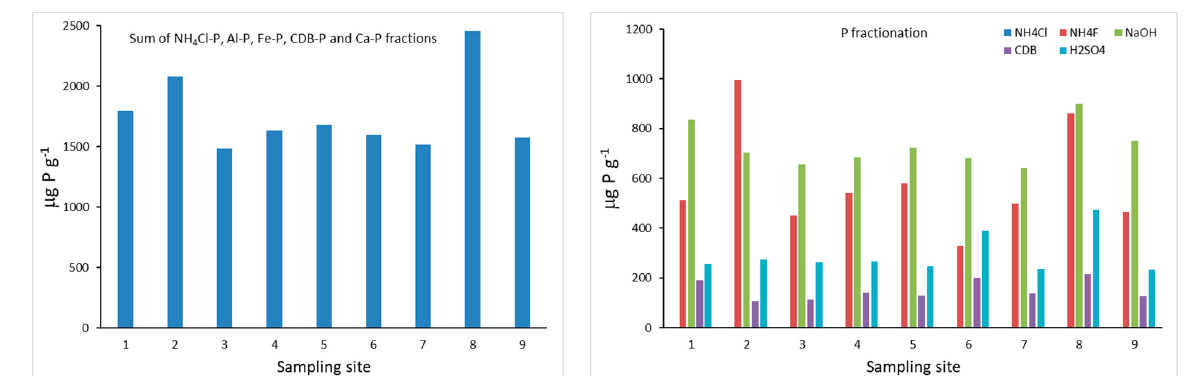
Figure 4. Chang and Jackson P fractions (mg P kg − 1 ) obtained for the bottom sediments of the Terragido reservoir. Phosphorus fractions: (cid:4) NH 4 Cl; (cid:4) NH 4 F; (cid:4) NaOH; (cid:4) CDB; (cid:4) H 2 SO 4 .